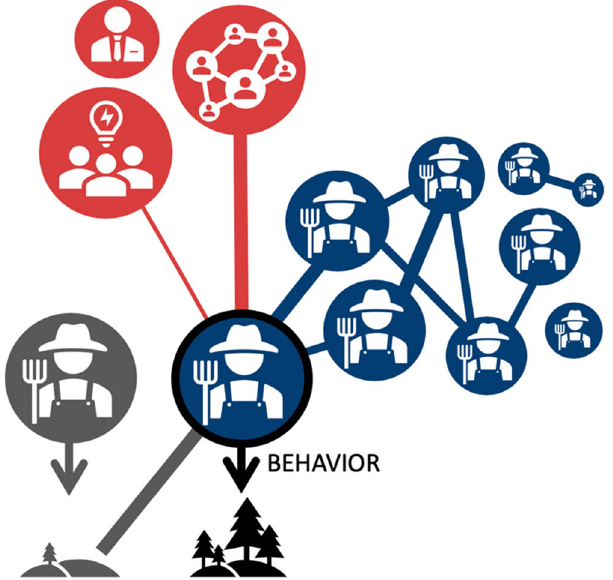
Figure 1. The concept of interacting social influences affecting environmental behavior. In this study, each landowner’s (blue node with black outline) decision about voluntary habitat conservation is affected by their interactions with a network of other landowners (blue nodes), three cross-scale actor groups (red nodes) and spatial knowledge diffusion mediated by change in biophysical context emerging from seeing other landowners’ conservation decisions (exemplified by one grey node). The width of connection between nodes illustrates the level of influence on landowner’s decision-making. The diversity and strength of social influences affecting decision-making vary among landowners. The figure was created using Microsoft PowerPoint version